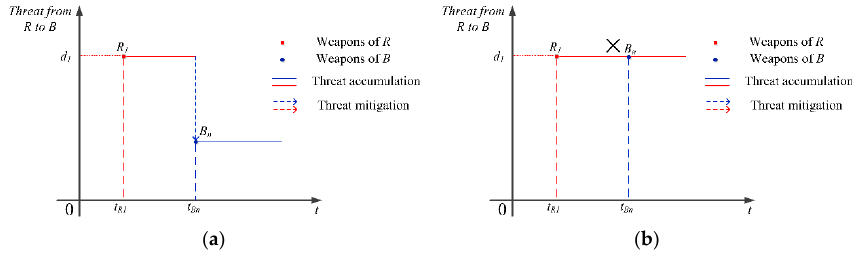
Figure 1. ( a ) Threat mitigation; and ( b ) threat accumulation.